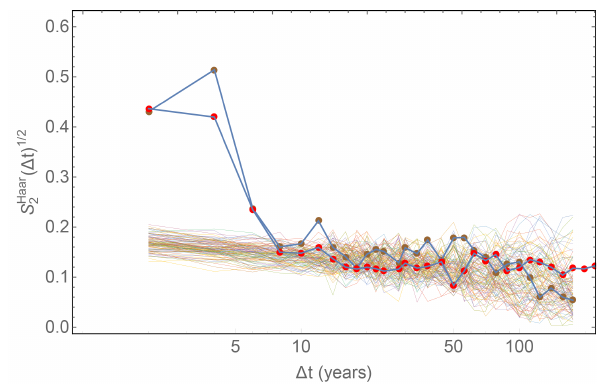
√ p (cid:104)| 3 (cid:15) ( t ), Figure 2. Brown bullets: Haar fluctuation function of (cid:49)T s + (cid:49)T v | 2 (cid:105) (red bullets) Figure 3. Haar structure functions where (cid:15) ( t ) is the first 195 years of the volcanic forcing record. Red and (cid:104)| (cid:49)T s+v | 2 (cid:105) (blue bullets are Haar fluctuations of ε ( t ). These two curves look similar to the corresponding curves in Lovejoy et al. (2016). The crucial issue is whether the difference between these two curves is statis- tically significant. The thin curves constitute Haar fluctuations of a 100-member ensemble of fractional Gaussian noises (fGn’s) of 195-year length with H = − 0 . 1 ( β = 2 H + 1 = 0 . 8). On timescale less than 10 years the fGn is not a good model for the internal noise because of the ENSO dynamics, but on longer timescales the flat Haar fluctuation curve suggests that an fGn with β ≈ 0 . 8 is a crude statistical model of the internal variability. The scatter of the Haar fluctuation in this ensemble gives an idea about the statistical uncer- tainty of an estimate of internal variability based on a 195-year-long |√ record. This uncertainty exceeds the estimate of 3 (cid:15) ( t ) − ε ( t ) | (the difference between the brown and the red curves); hence this differ- ence is not statistically significant.